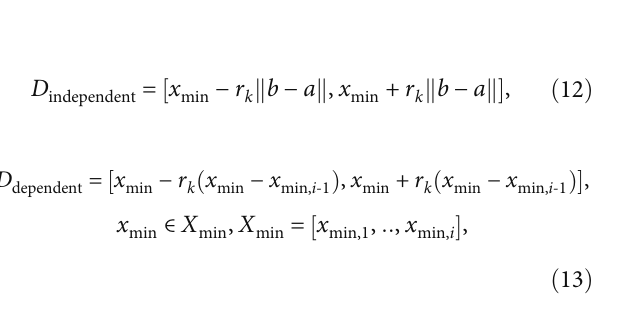
Figure 4: Kriging prediction with initial sample